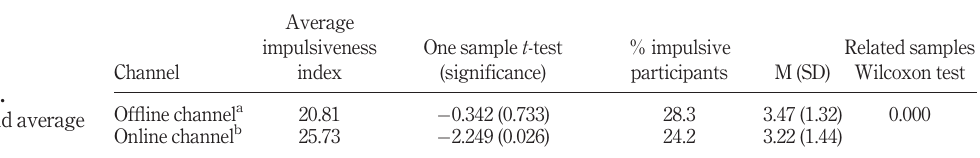
values of impulsiveness of the offline and online